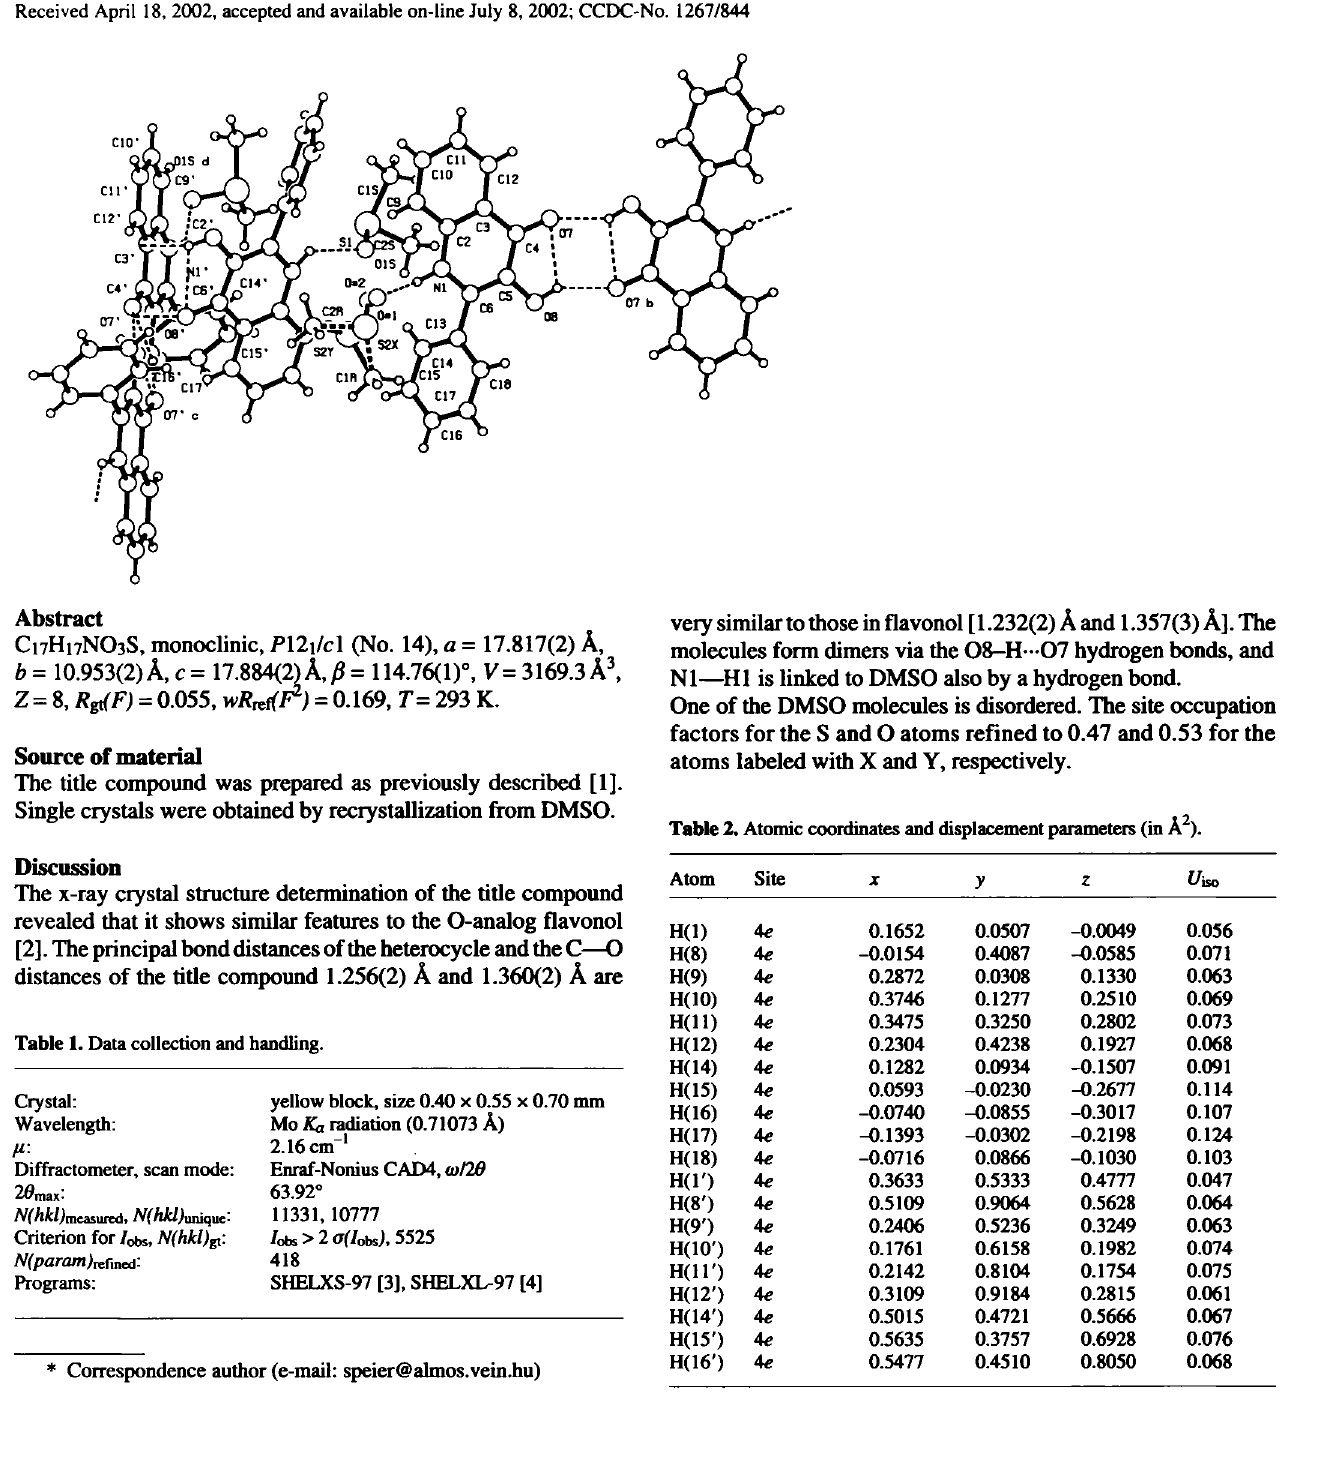
Table 2. Atomic coordinates and displacement parameters (in Â 2